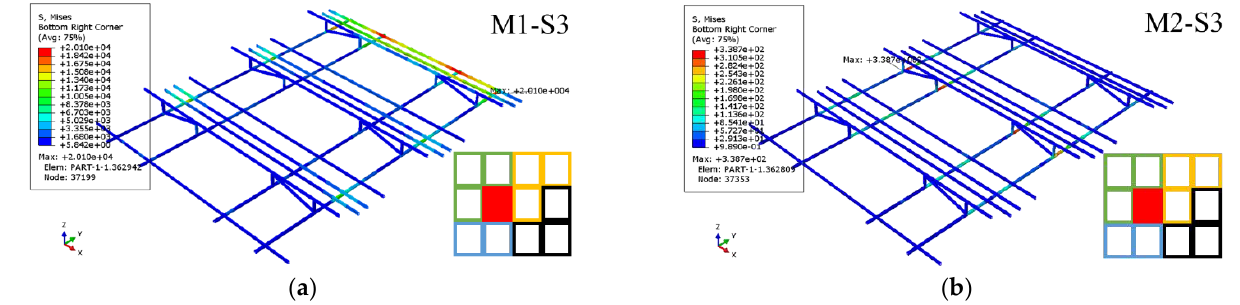
Figure 11. Maximum von Mises stresses in POSMAC frames: ( a ) M1-S3 (uneven mass and wave incident angle of 90°); ( b ) M2-S3 (even mass and wave incident angle of 90°).